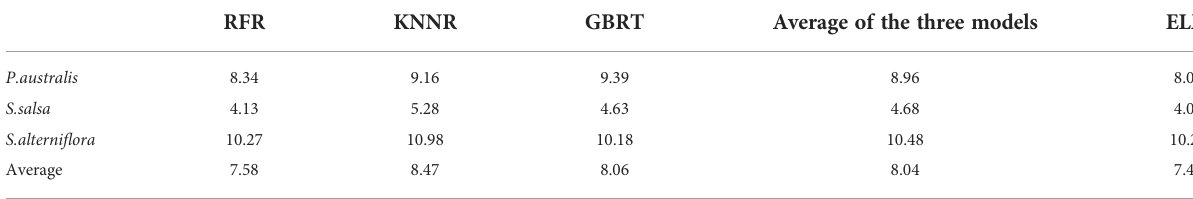
TABLE 4 RMSE (%) of the estimated fractional cover based on cloud-removed images in Scenario 1. RFR, Random Forest Regression; KNNR, K-Nearest Neighbor Regression; GBRT, Gradient Boosted Regression Tree; ELM, Ensemble Learning Model. RFR KNNR